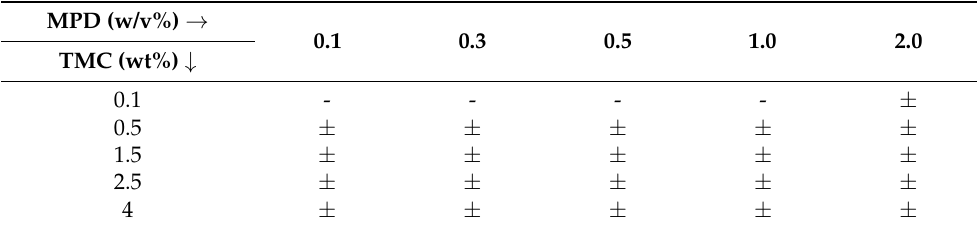
Table 2. Visual determination of PA film formation in vial tests for various concentrations combina- tions of MPD in water and TMC in